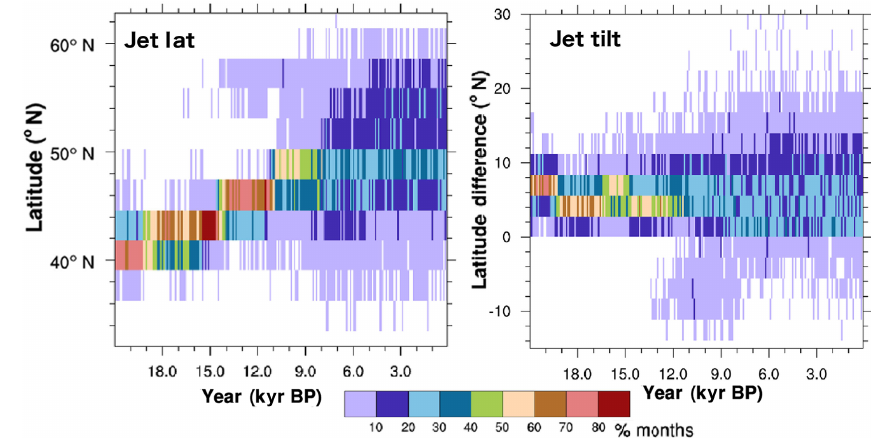
Figure 9. Frequency maps of NAtl mean jet latitudes and tilt averaged over 700 to 925hPa and aggregated over 10 successive winter seasons and all ensemble members of the FullyTrans experiment. Winds are averaged over 270 to 360 ◦ E when calculating jet latitude and tilt is defined as the difference in latitudes calculated over 330 to 360 and 270 to 300 ◦ E. Frequencies represent the percentage of months (out of a total of 120 months) that the jet was identified at a particular latitude, where each latitude bin has a width of 2.8 ◦ at T42.